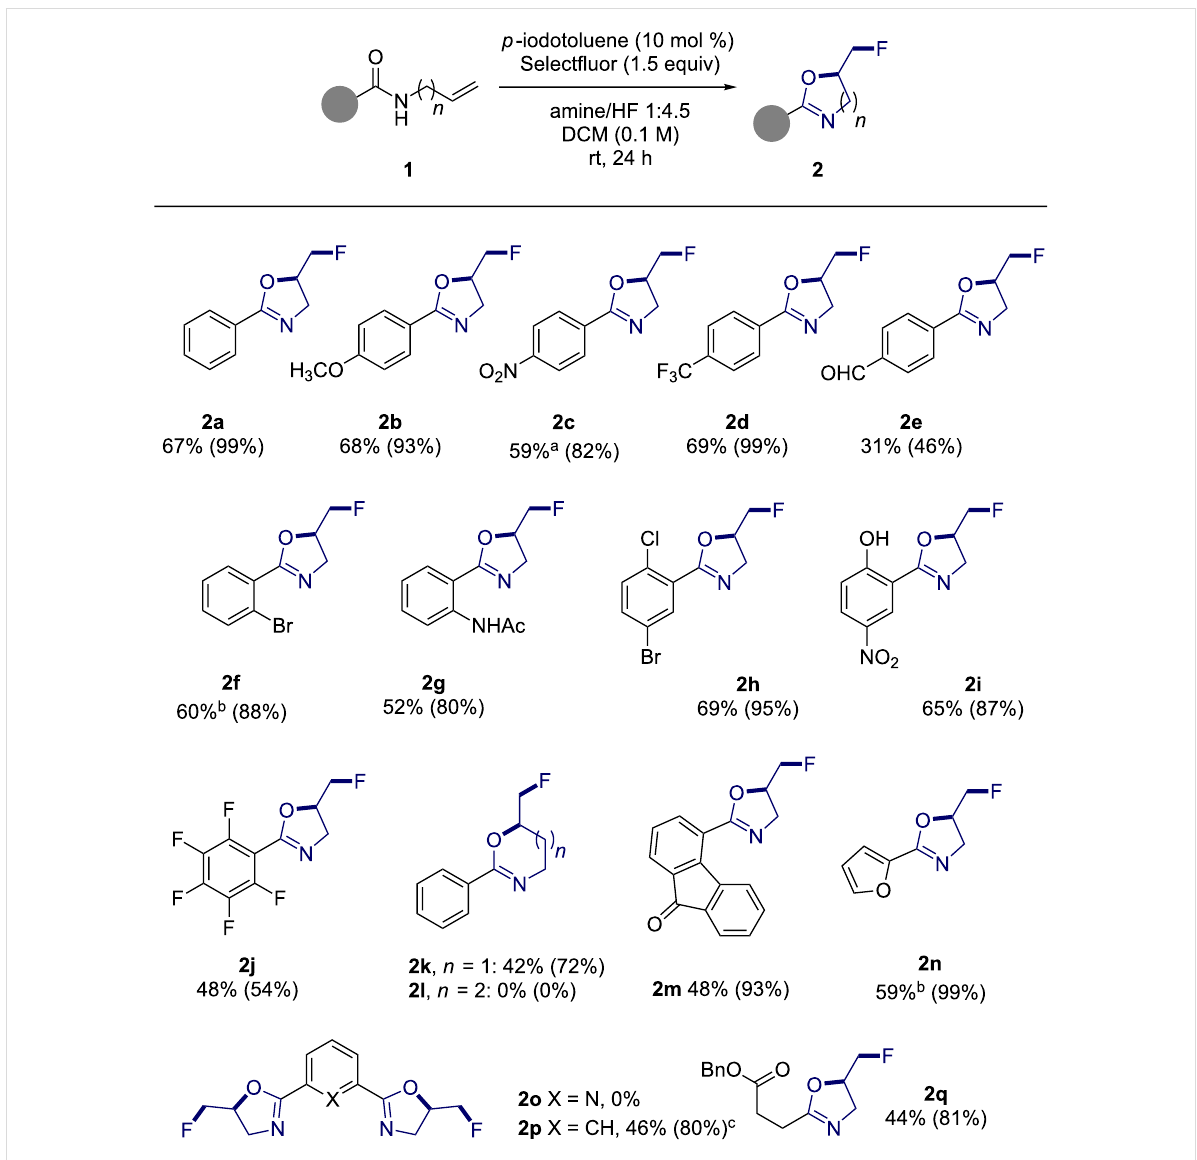
Figure 3: Substrate scope. a Reaction conducted on 1 mmol scale. b Reaction time increased to 40 hours. c Reaction time increased to 32 hours. Yields refer to isolated values whilst NMR yields are given in parentheses ( 19 F NMR using ethyl fluoroacetate as an internal standard).